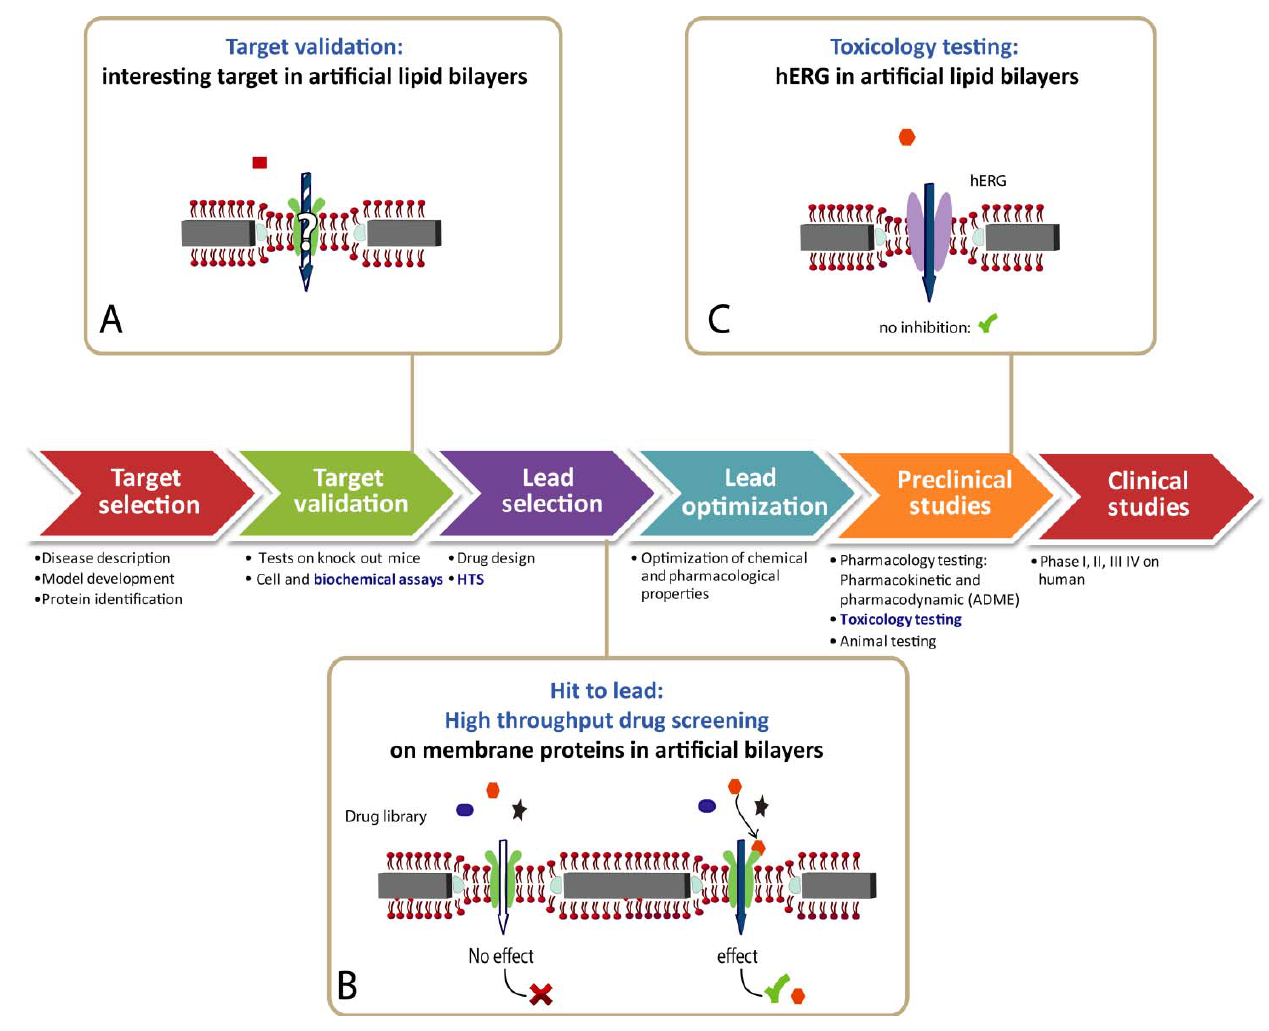
Figure 6. Drug discovery